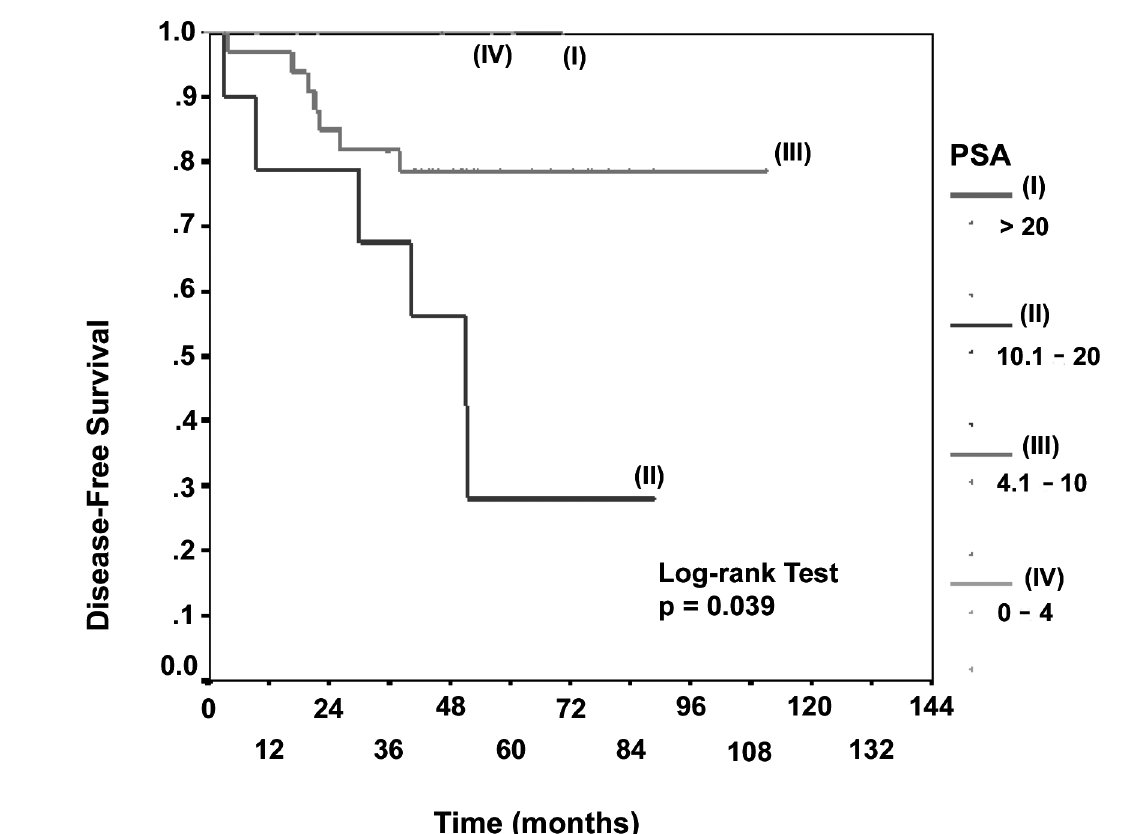
Figure 2 – Probability curve for recurrence-free survival according to PSA categories in patients with clinical stage T1c, and Gleason scores 7 -